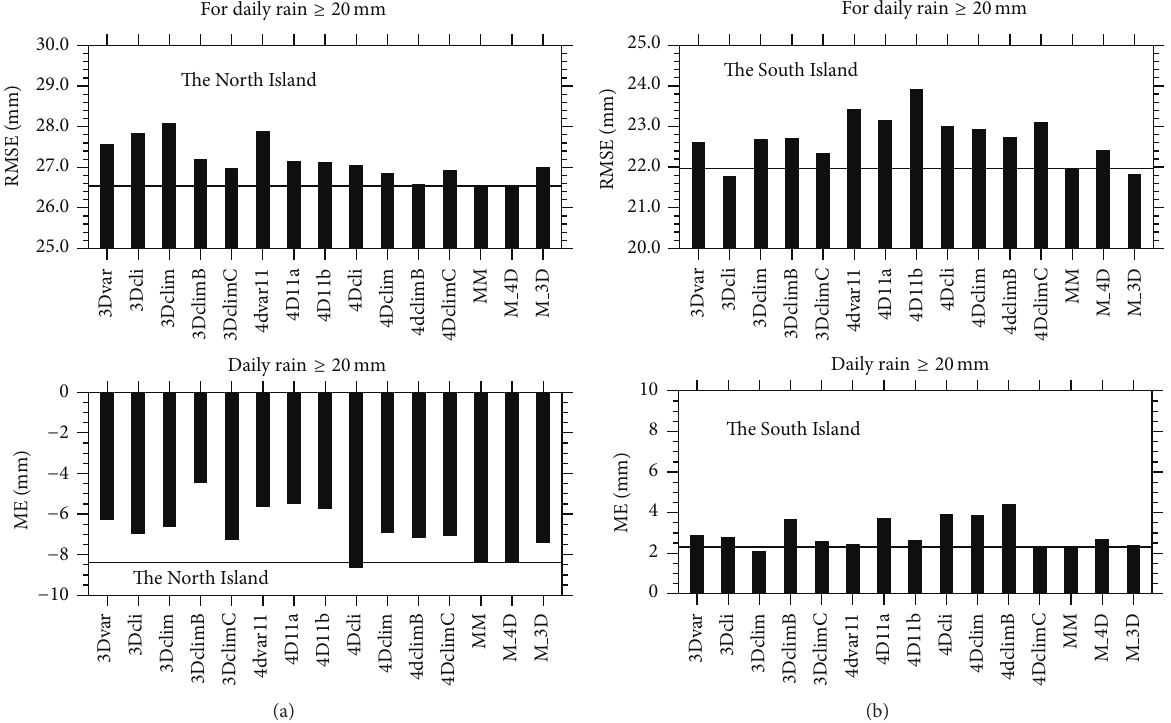
Figure 10: As in Figure 8 but for mod-heavy rainfall over the North Island (a) and over the South Island (b).